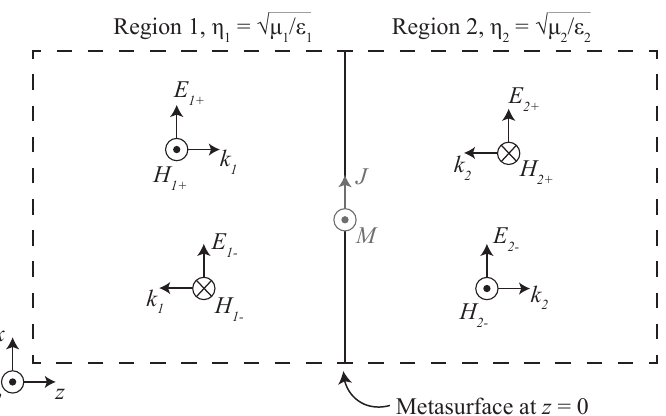
Figure 1. The geometry of a metasurface between two regions with different material properties. The equivalent surface current densities J (electric) and M (magnetic) describe the interaction of the metasurface with the tangential fields. Under illumination by a normally incident plane wave, each region can contain two plane waves that are denoted by + for a wave propagating toward the surface or − for a wave propagating away from the